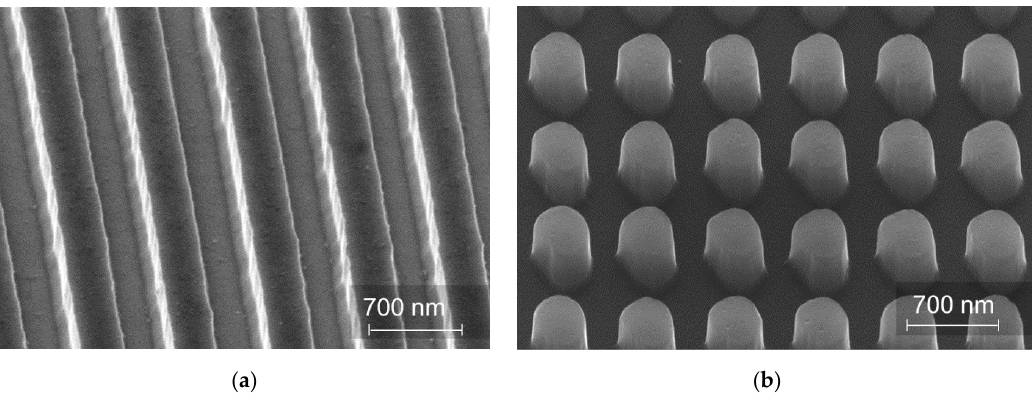
Figure 2. ( a ) SEM detail of 1D PhC structure and ( b ) SEM image of 2D pillar structure arranged in 2D square symmetry with period of 700 nm.